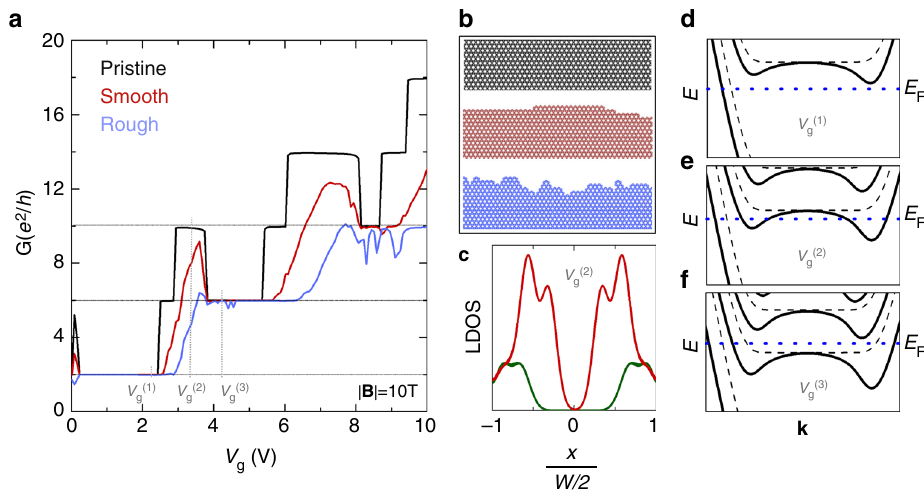
Fig. 3 Tight-binding simulation of CQS. a Simulated conductance, including non-uniform gating effects, at | B | = 10 T for a pristine nanoribbon (black), and ribbons with smooth (red) and rough (blue) edges. The CQS peaks are only fully suppressed by the stronger disorder (see Methods). b Schematics of the different edges considered in a . c Local density of states (LDOS) across a pristine ribbon at a gate voltage V g (2) that displays a CQS peak. Non-uniform gating (red) introduces states in the ribbon bulk, which are not present for uniform gating (green). d – f Band structure near the Fermi level E F for three gate voltages ( V g (1) , V g (2) , V g (3) ), marked in panel a near a CQS peak, respectively. Non-uniform gating introduces a clear distortion of the band structure relative to the uniform case (dashed), which opens new conductance